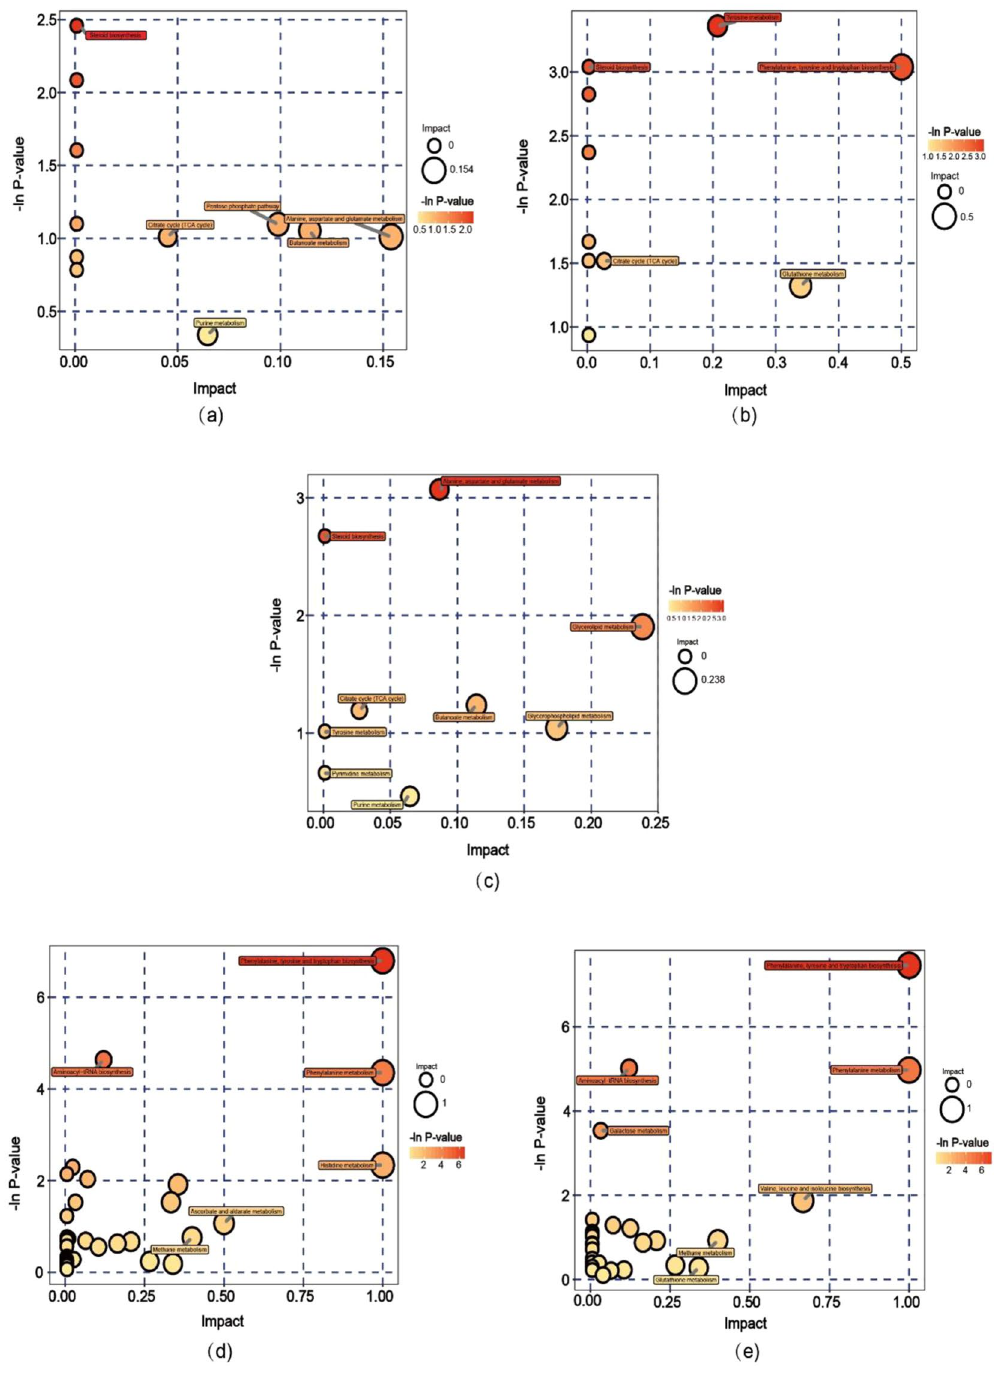
Figure 4. Pathway analysis bubble plots showing differences between comparisons for: ( a ) H-F-S and R-F-S, ( b ) H-M and R-M, ( c ) H and R, ( d ) H-F-S and H-M, and ( e ) R-F-S and